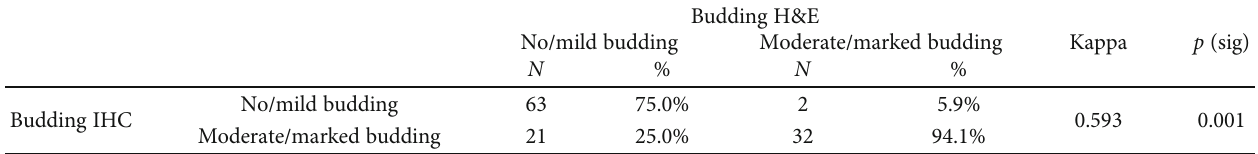
Table 2: Agreement between H&E and IHC as regards budding detection.